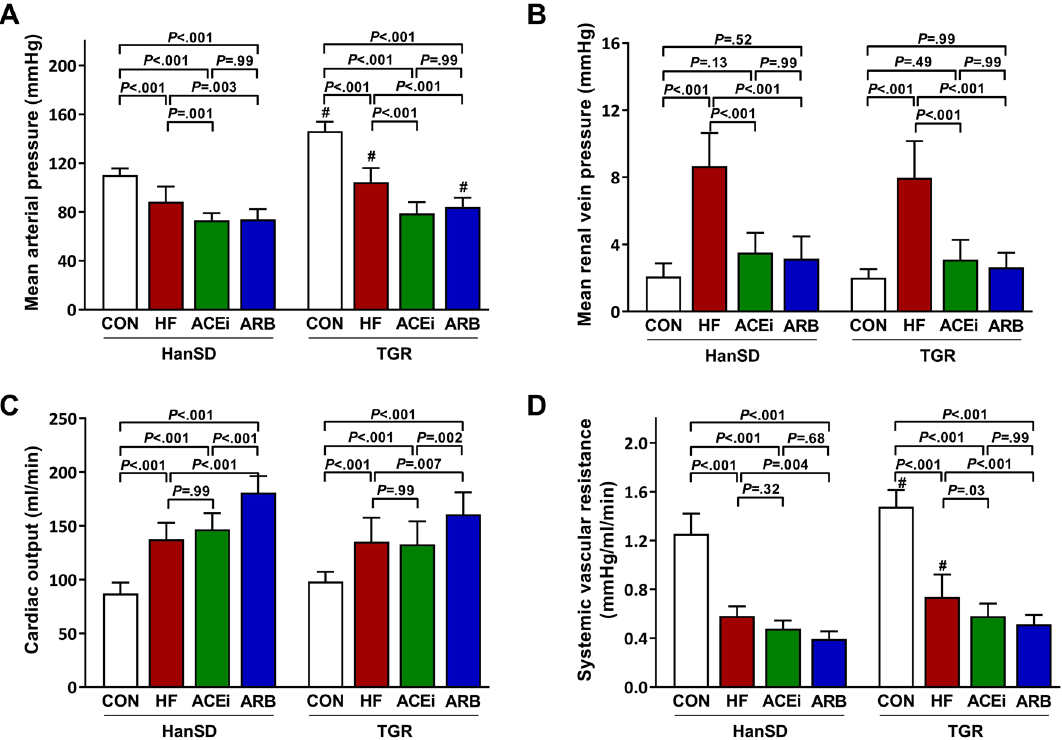
blocker-treated (ARB) HanSD and TGR rats 20 weeks after sham or ACF operation (5 weeks in HF TGR rats due to high mortality). Data presented as mean ± SD (n = 10 in each group). # P < 0.05 compared to HanSD